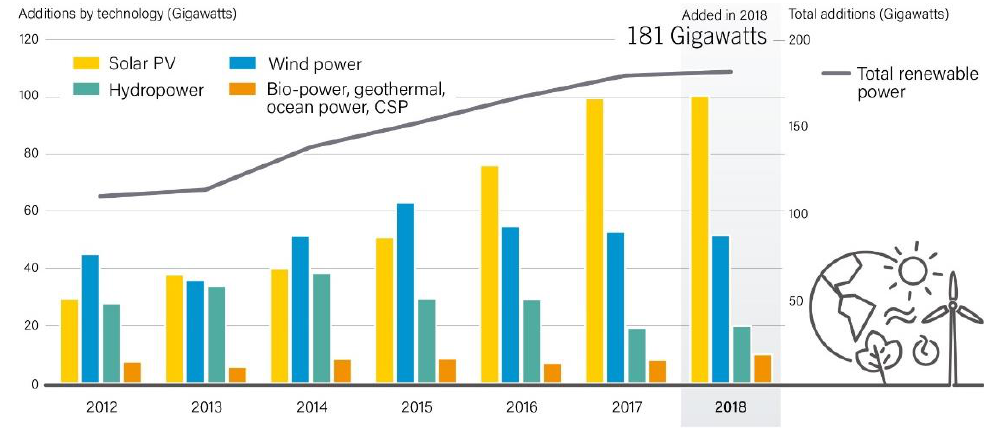
Figure 1. Global stats of renewable generation [3].